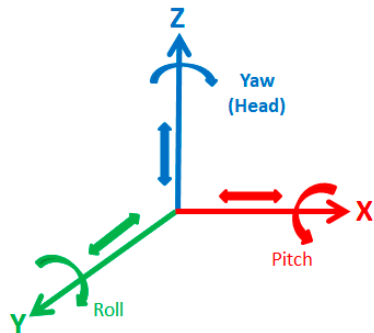
Figure 6. Coordinate system including six degrees of freedom, three linear and three angular (adapted from [44]).